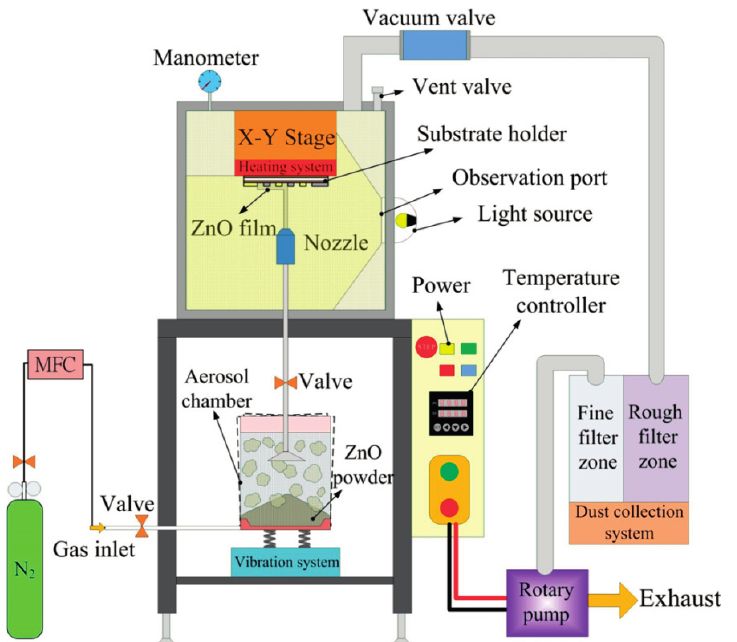
Figure 1. Schematic diagram of the aerosol deposition